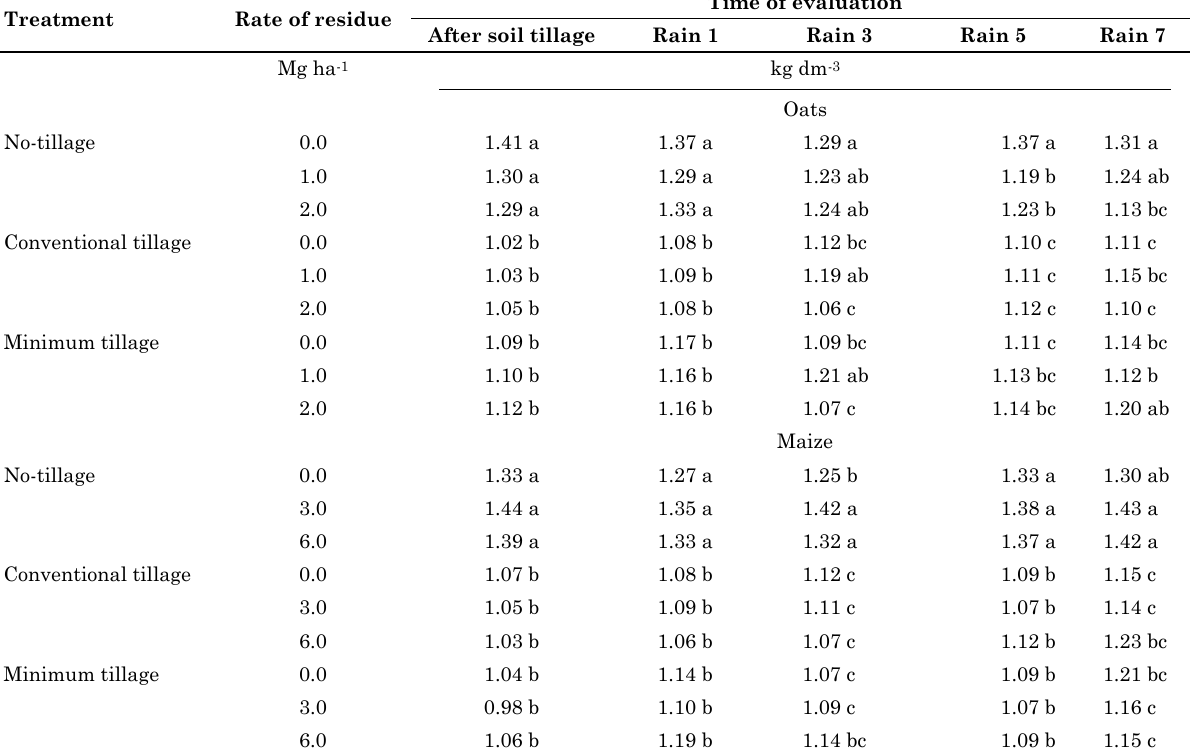
Table 2. Values of bulk density in the treatments under diverse rates of oat and maize residue in the 0-0.05 m soil layer